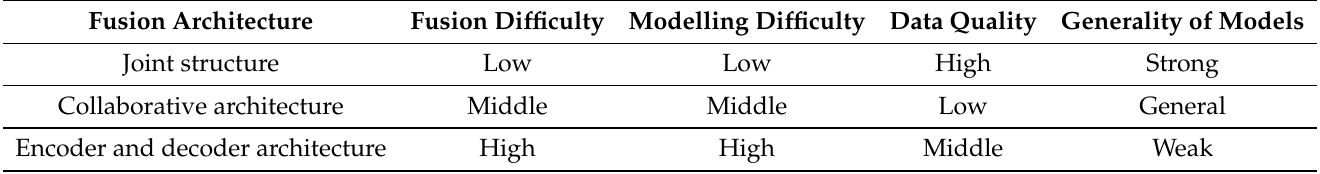
Table 1. A comparison of the advantages and disadvantages of different fusion